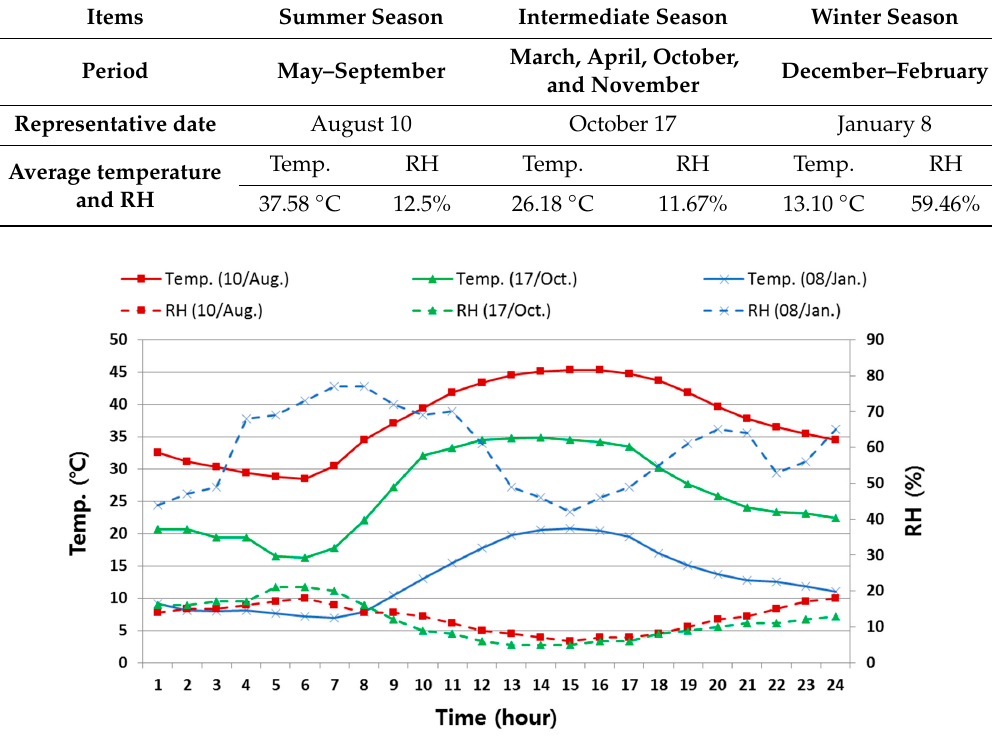
Figure 16. Temperature and RH distribution of each representative day.